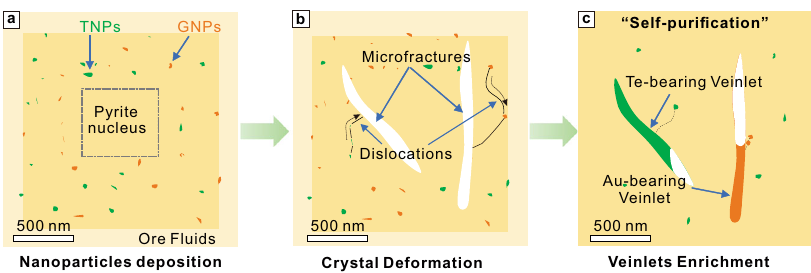
Fig. 4 Illustrations of formation processes of Au-, Ag-, and Te-bearing veinlets in deformed pyrite. a Enrichment of gold-bearing nanoparticles (GNPs) and Te-bearing nanoparticles (TNPs); b the metamorphism-induced formation of microfractures and dislocations in pyrite; c the formation of Au-, Ag-, and Te-bearing veinlets concentrated from the host pyrite through pipe diffusion with